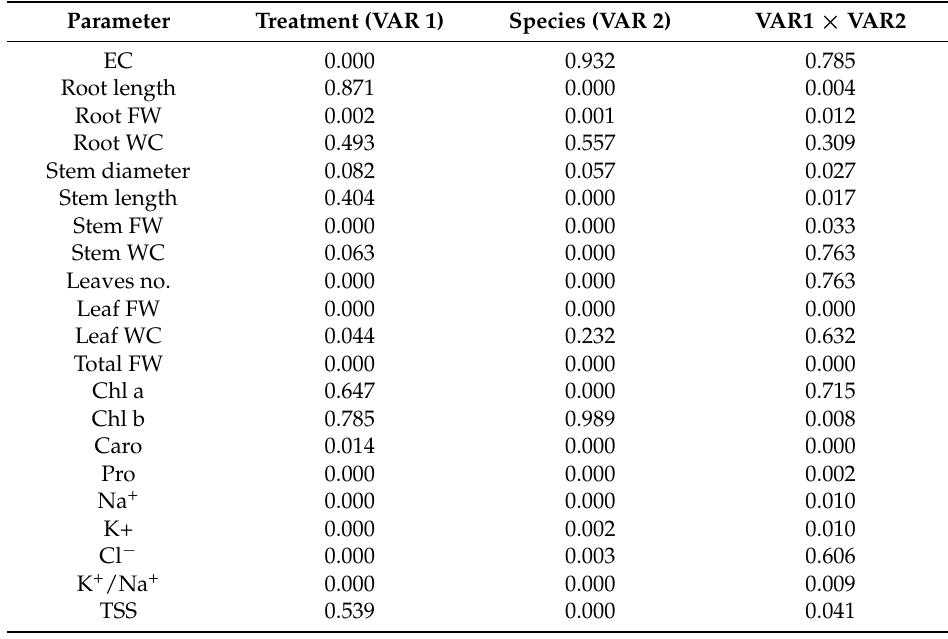
Table 2. Significance of variation ( p values) according to two-way ANOVA testing the effect of treatment (Variable 1, VAR 1) and genotype (Variable 2, VAR 2) and their interactions (VAR 1 × VAR 2) for all morphological and biochemical traits analysed. Chl a, chlorophyll a; Chl b, chlorophyll b; Caro, total carotenoids; Pro, proline; TSS, total soluble sugars.